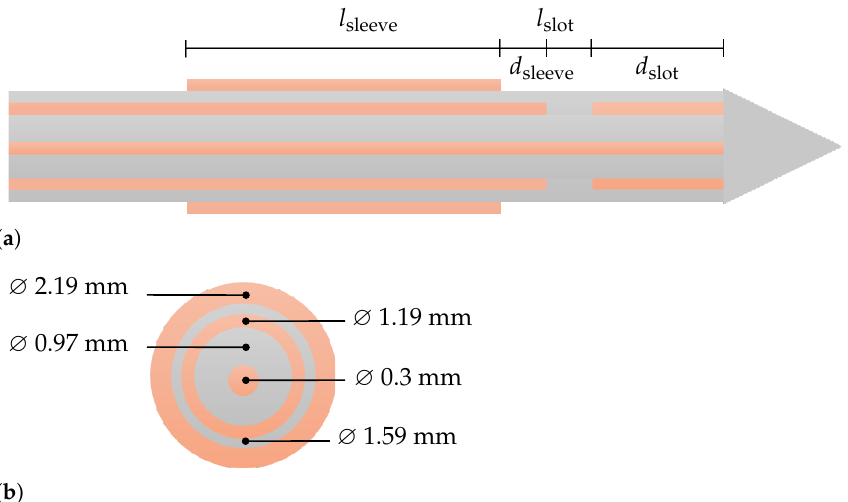
Figure 1. ( a ) Structure of the open-ended coaxial slot antenna with design parameter l sleeve , d sleeve , l slot , and d slot ; ( b ) cross-section of the coaxial cable with a diameter of 1.19mm surrounded by a Teflen isolation layer and a floating sleeve. Dielectric material is colored in gray and metallics are